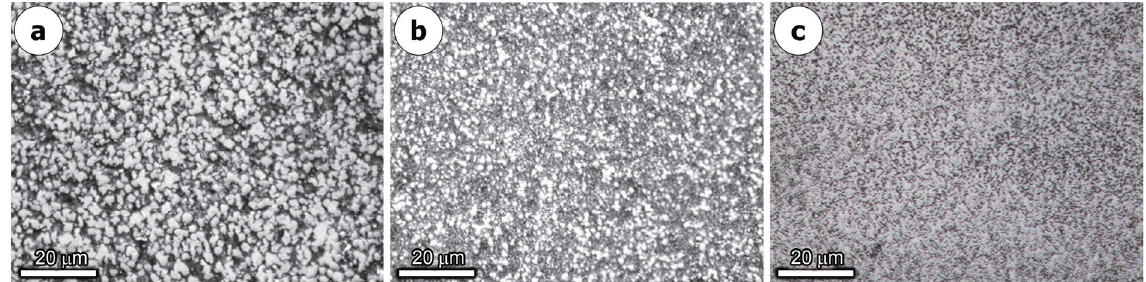
Fig. 1 Optical micrographs of (a) tool steel A, (b) tool steel V, and (c) tool steel O (magnification